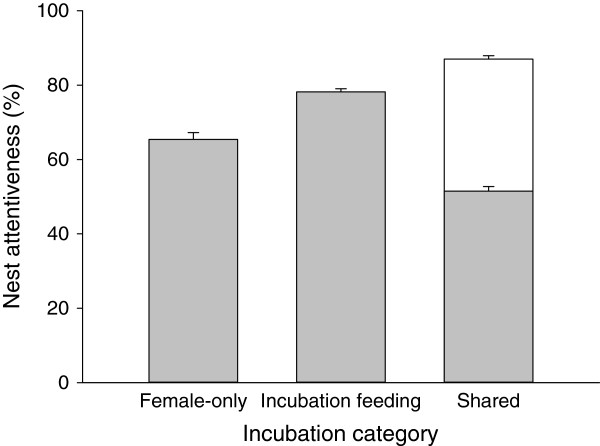
Total nest attentiveness in species with different incubation strategies. Female attentiveness is depicted in grey, male attentiveness in white.